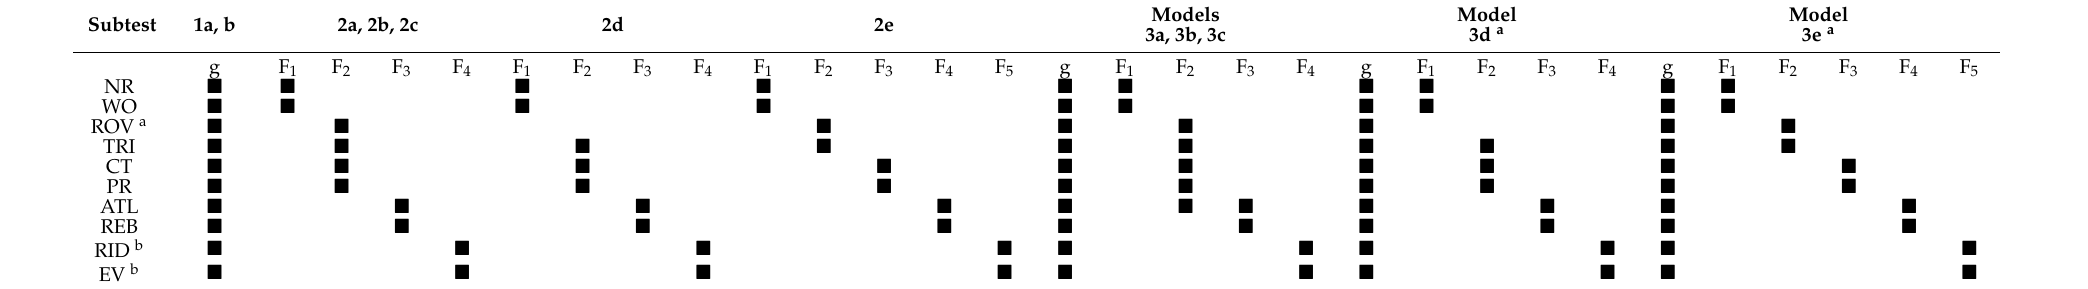
Table 3. Overview of KABC-II subtest configurations for CFA models.